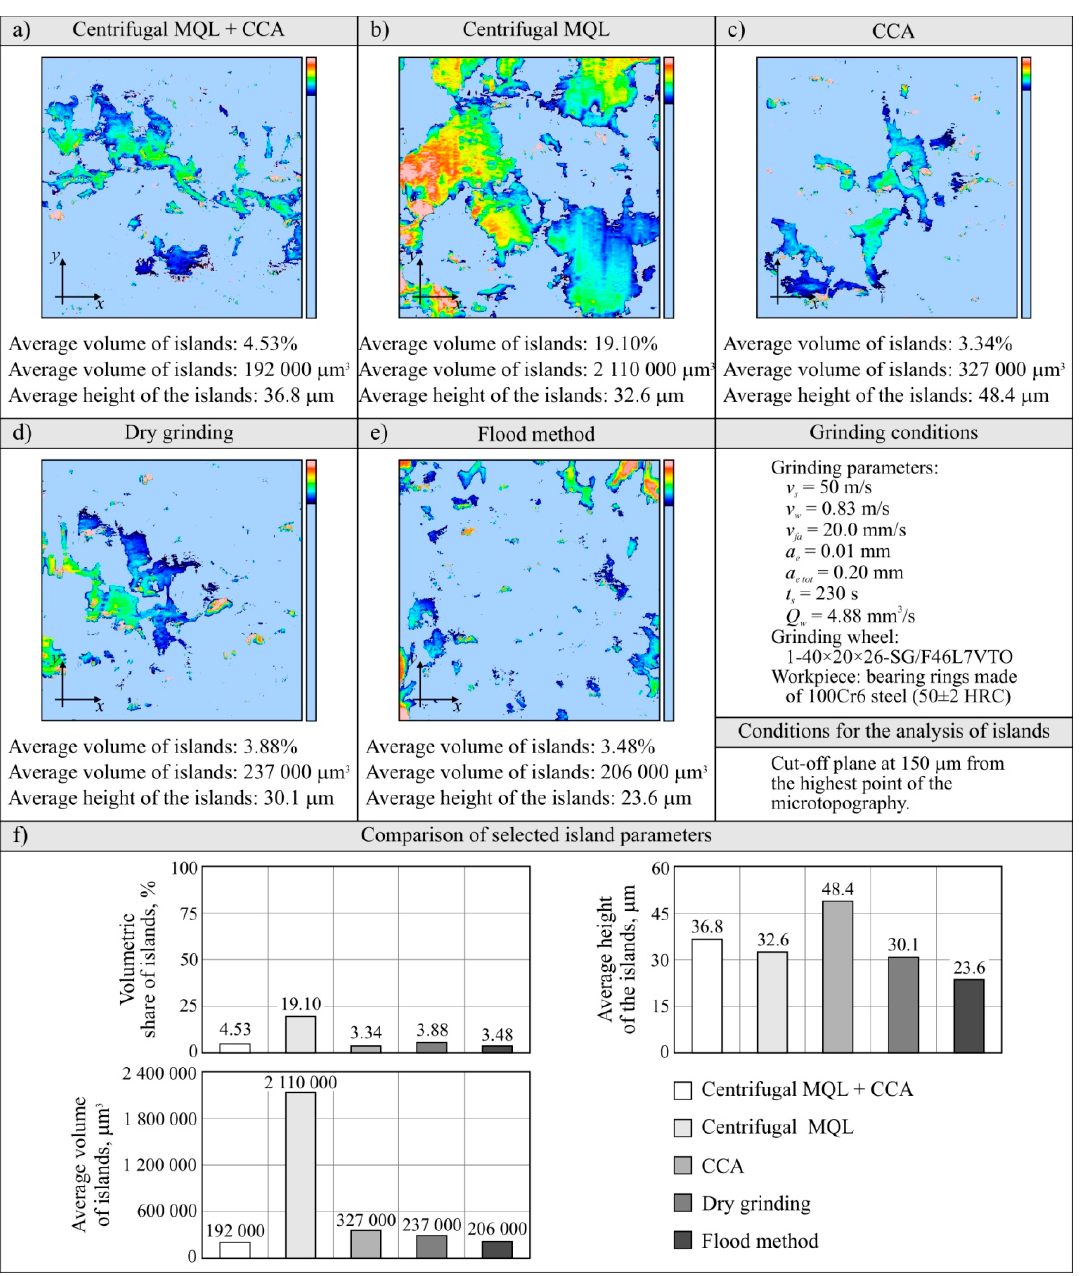
Figure 12. Results of an island analysis (volume and height of islands) separated on the GWAS ( a – e ), as well as comparison of selected island parameters ( f ).